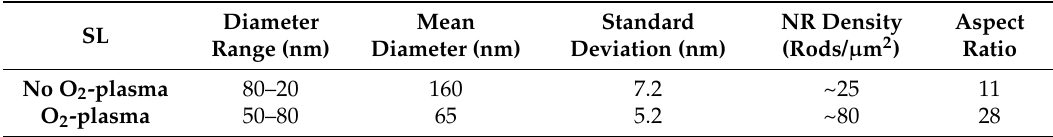
Figure 3. FE-SEM plane views of NRs grown on ( a ) as-coated and ( b ) O 2 -plasma-treated (for 9 min) SLs. Each inset shows the magnified views of the grown NRs. Histograms of diameter distribution for the NRs grown on as-coated and O 2 -plasma-treated (9 min) SLs are also shown in ( c ) and ( d ), respectively. Table 1. Summary of morphology statistics measured from the FE-SEM images of ZnO NRs grown on as-coated and O 2 -plasma-treated SLs (for 9 min).